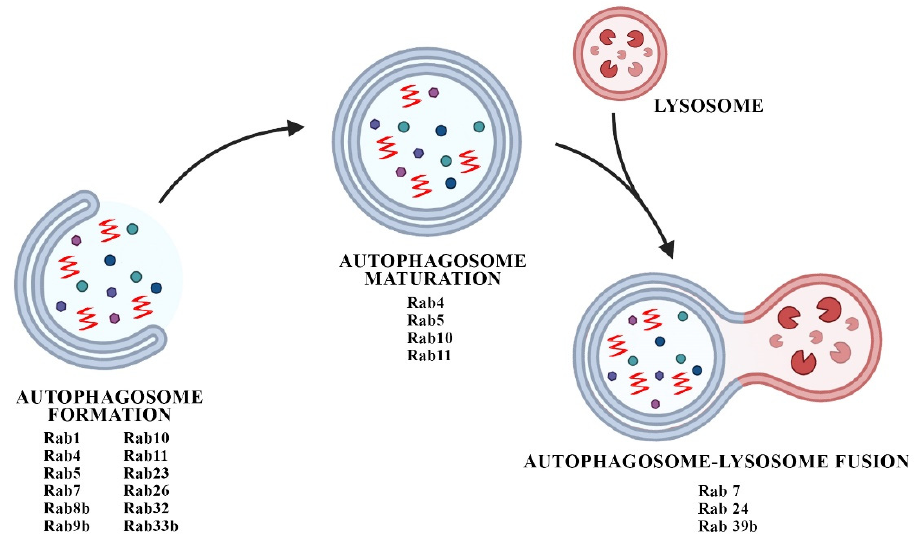
Figure 2. The cartoon summarizes the Rabs participating in the different phases of macroautophagy, from autophagosome formation to its fusion with the lysosome. Table 3. Involvement of Rabs in autophagy and autophagy-related synaptic alterations.